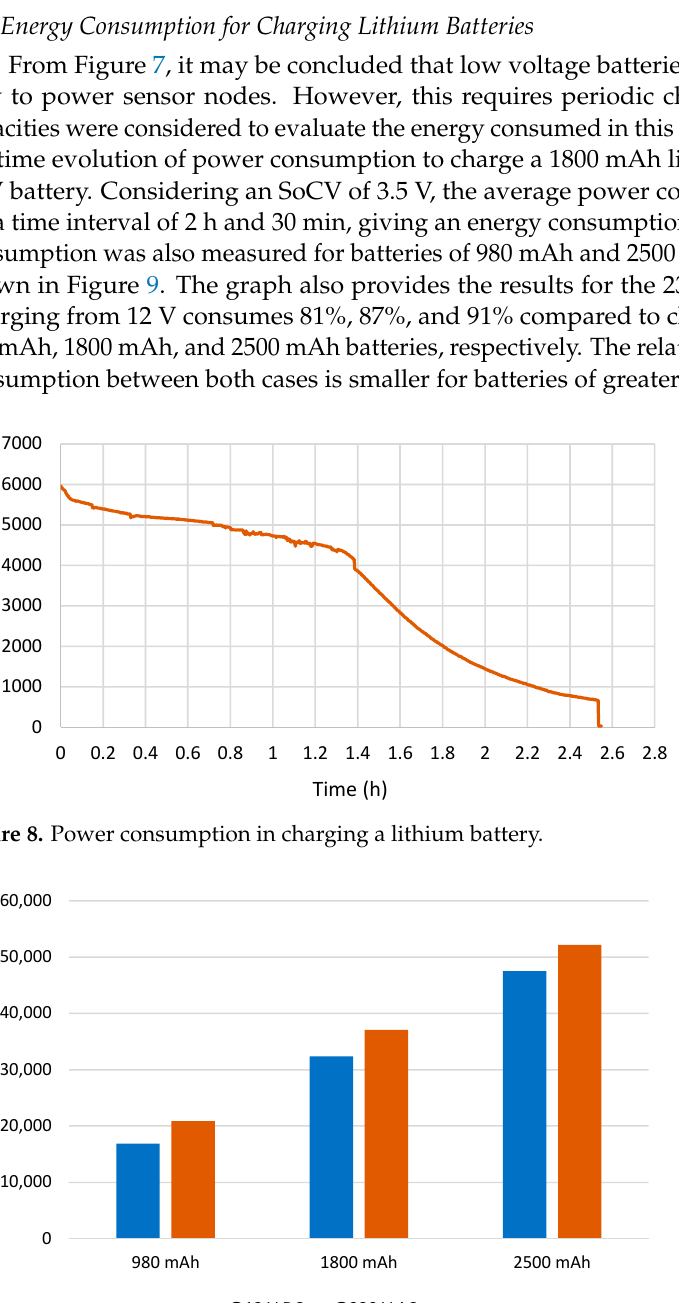
Figure 9. Energy consumption for charging batteries of different capacities and for two sources of